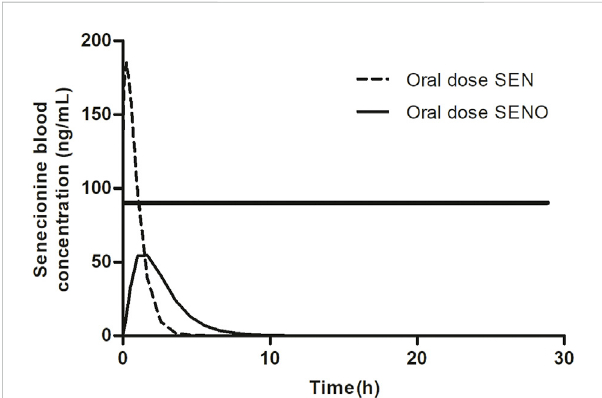
FIGURE 2 SEN blood concentration versus time pro fi le upon dosing SEN or anequimolarconcentrationofrelatedSENO.Ahypotheticalthreshold (horizontal blackline)forthebloodSENconcentrationindicateswhen the capacity for GSH based detoxi fi cation of the pyrrole intermediate is exceeded. The kinetic pro fi le presented was based on results from our previous publication (Widjaja et al.,